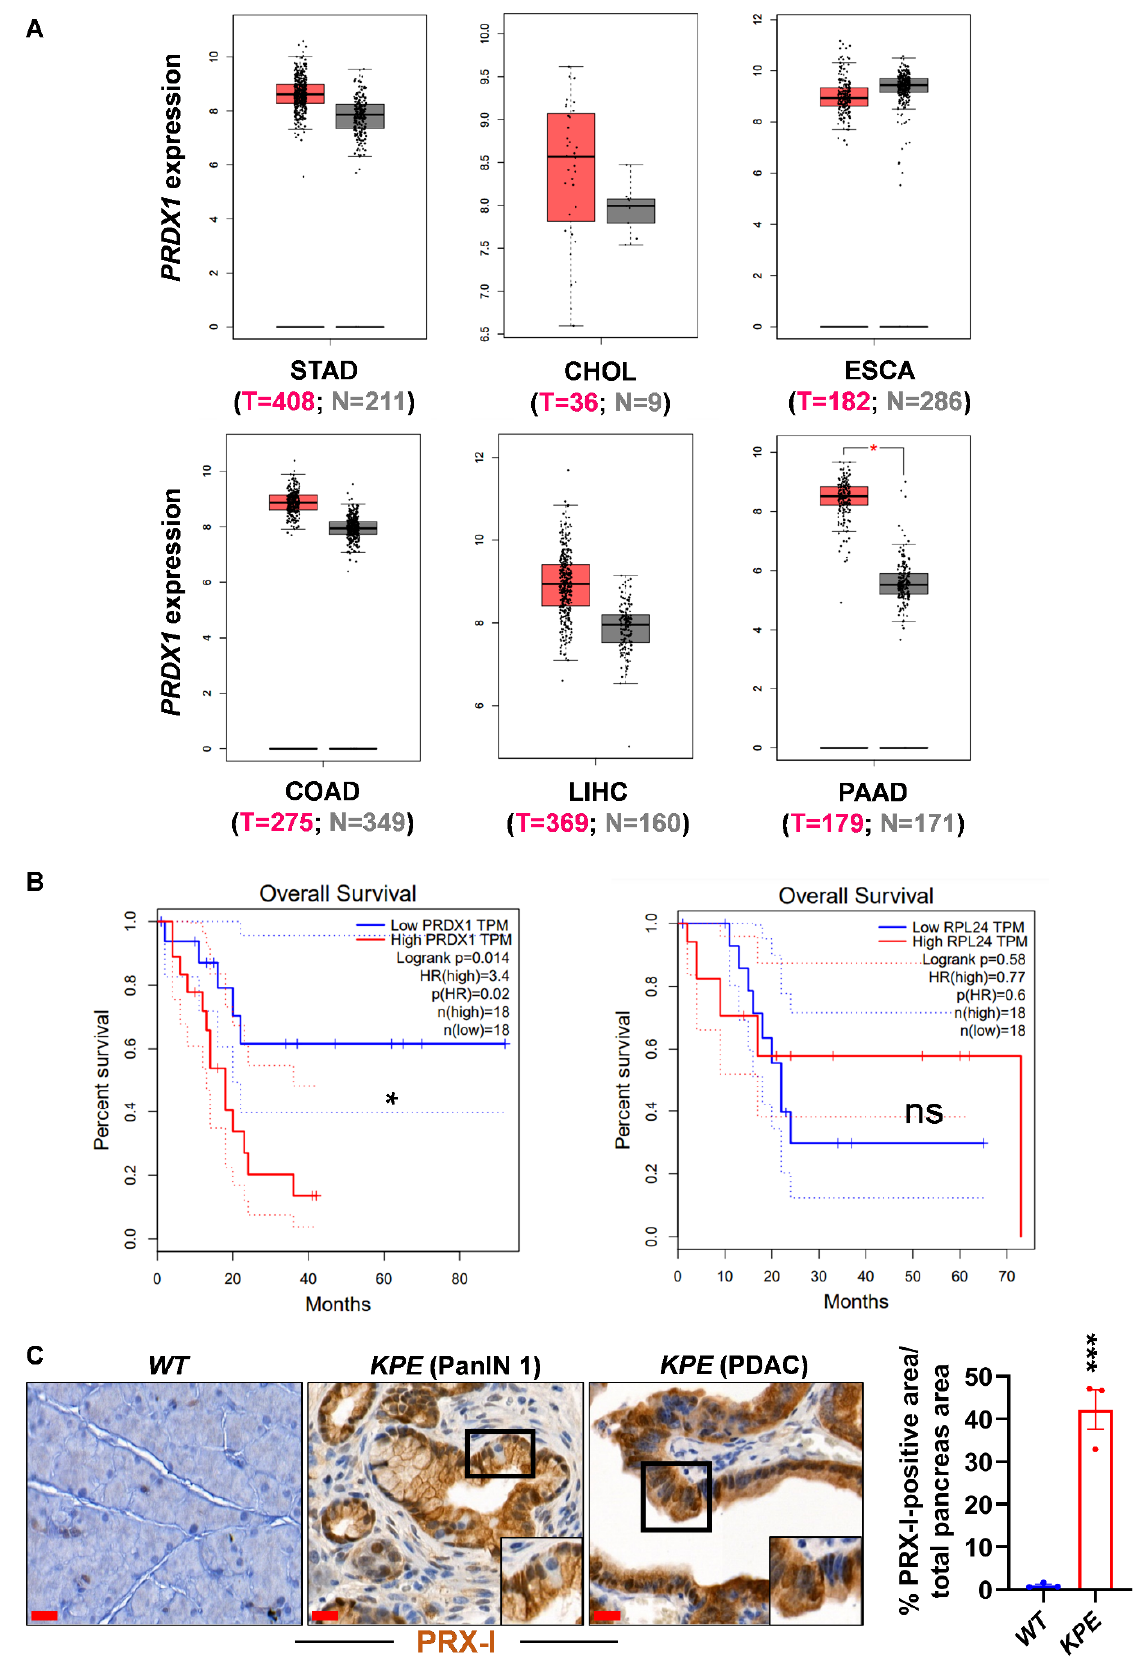
Figure 1. Peroxiredoxin-I (PRX-I) expression is upregulated in pancreatic tumors. ( A ) Peroxiredoxin-1 gene ( PRDX1 ) ex- pression in the indicated gastrointestinal tumors (pink) and their corresponding normal tissues (grey) available from the